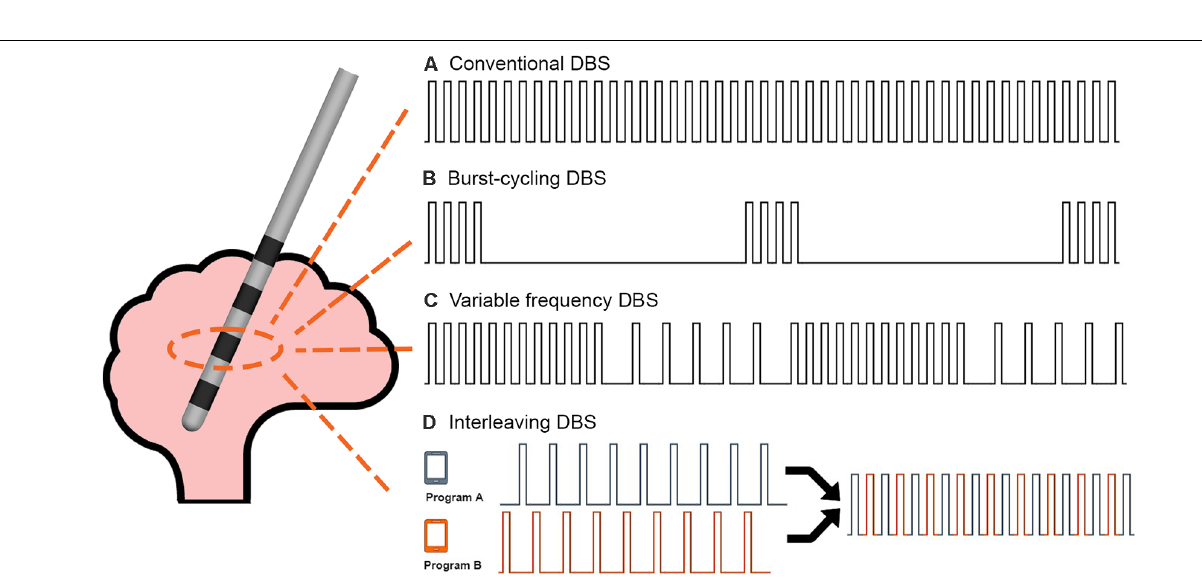
FIGURE 2 | DBS stimulation paradigms: a comparison of the stimulation delivery patterns between (A) Conventional DBS, (B) Burst-cycling DBS, (C) Variable frequency DBS, and (D) Interleaving DBS is shown. Burst-cycling DBS delivers four pulses at the same intra-burst frequency as conventional DBS but with an inter-burst frequency of 4, 10, or 15 Hz. The illustrated example shows 4-Hz burst-cycling